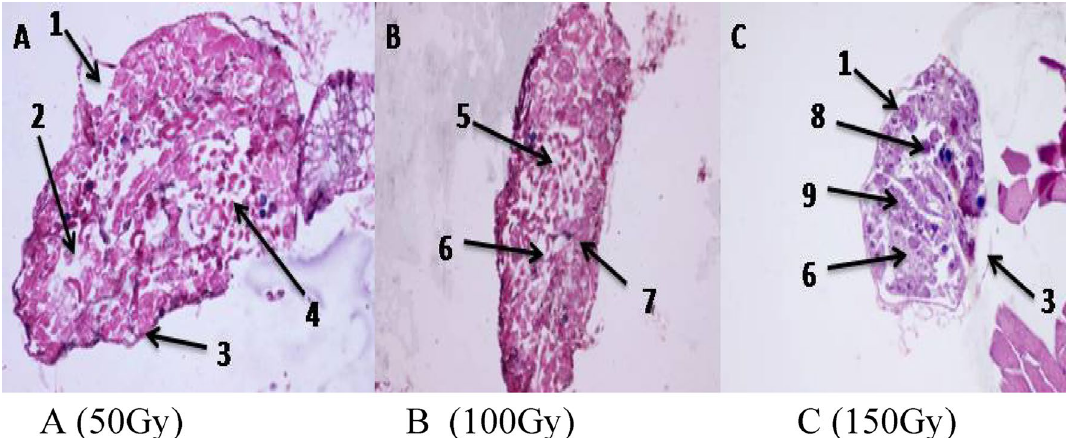
Figure 5. Cross section of testis tubules of irradiated male with ( A ) (50 Gy), ( B ) (100 Gy) and ( C ) (150 Gy). 1, Thin testicular wall; 2, absent spermatogonia; 3, irregular wall and ruptured testicular wall; 4, broken interfollicular partitions; 5, individual sperms; 6, absorbed spermatids; 7, broken sperm bundle and retardation in spermatogenesis; 8, dark masses; 9, clusters of